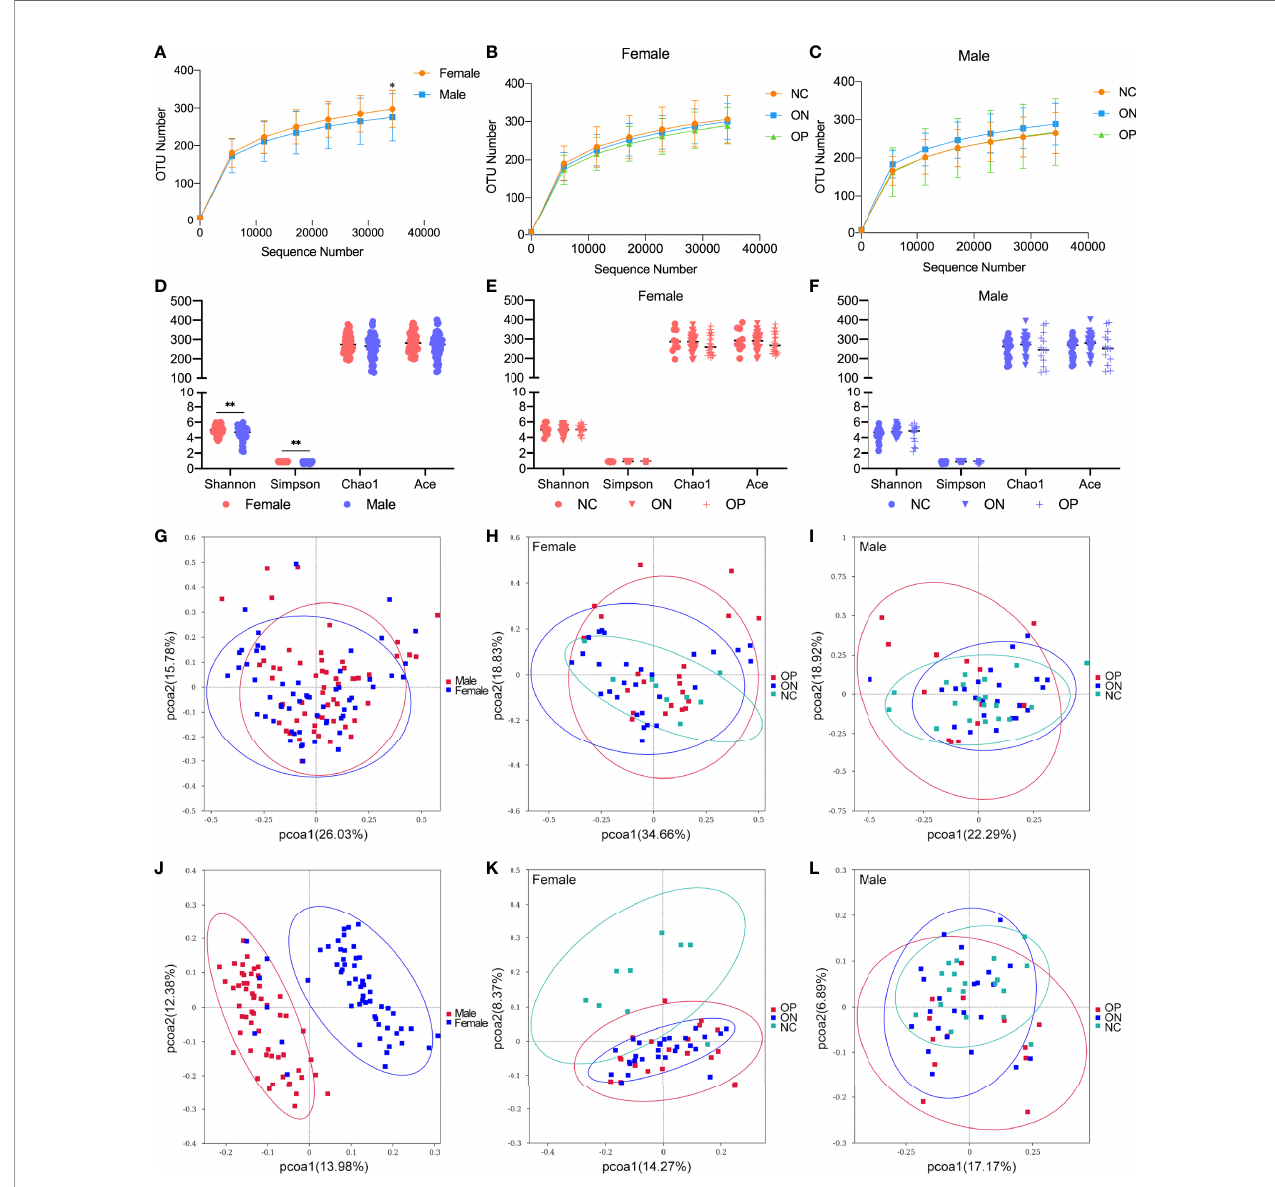
FIGURE 3 | Observed OTUs, alpha diversity indexes, and OTU-level PCoA analysis in females and males. (A – C) Observed OTUs in different levels of sequences/ sample in female and male subjects, and in the subgroups of females and males. (D – F) Alpha diversity indexes including Shannon, Simpson, Chao1, and ACE in female and male subjects, and in the subgroups of females and males. (G – I) OTUs-based weighted unifrac PCoA analysis of the 16S sequencing in female and male subjects, and in the subgroups of females and males. (J – L) OTUs-based unweighted unifrac PCoA analysis of the 16S sequencing in female and male subjects, and in the subgroups of females and males. *P < 0.05, **P <